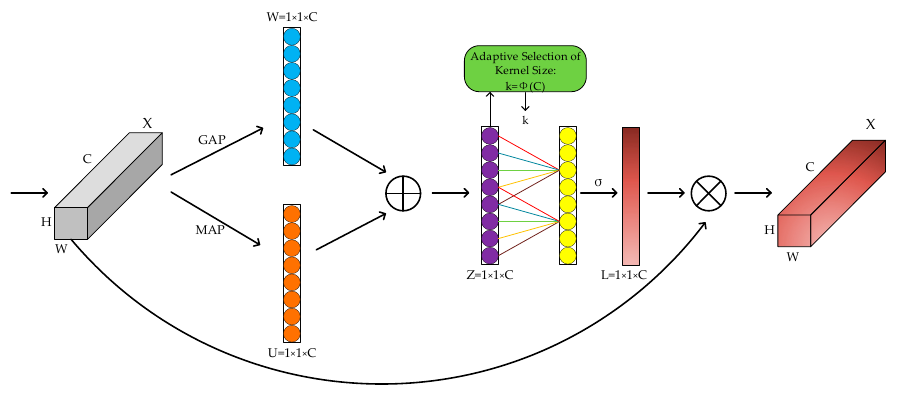
Figure 3. BECA structure.